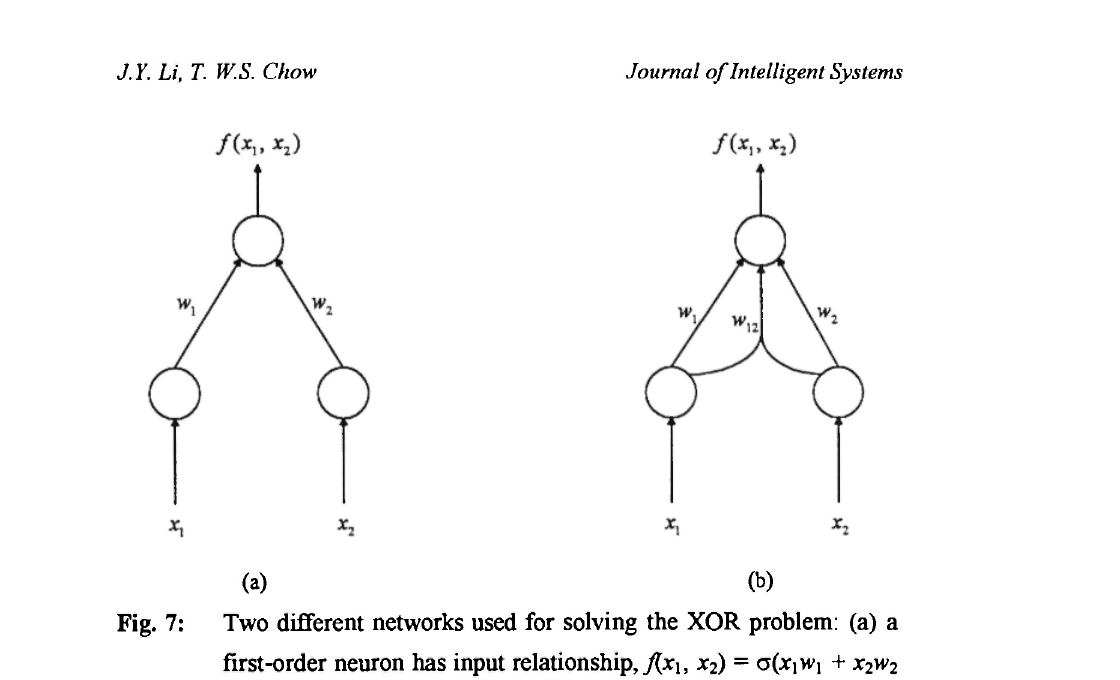
Two different networks used for solving the XOR problem: (a) a first-order neuron has input relationship, flx + Θ), which is unable to solve the XOR problem no matter how the weights and the threshold are chosen; (b) a partially-con- nected 2nd-order neuron has input-output relationship, yfo, x a(X]Wi + x w +X]X w\2 + Θ), which can solve the XOR problem 2 2 2